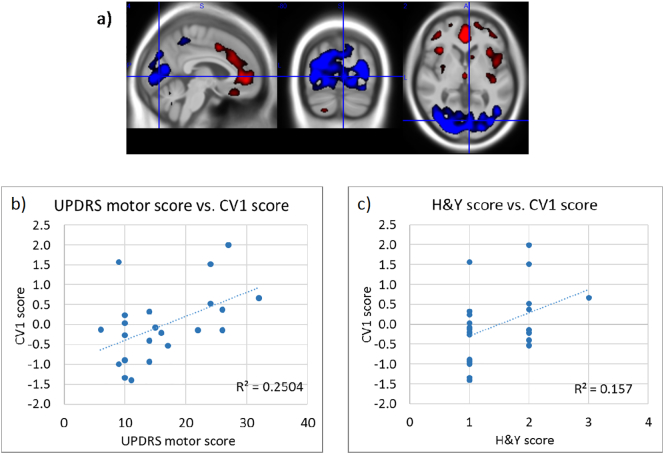
a) CV1 pattern for classifier trained on PD subjects from Hoehn & Yahr stages I vs. II & III; b) Correlation between CV1 scores and UPDRS motor scores generated through Leave-One-Out testing; c) Correlation between Leave-One-Out CV1 scores and H&Y stage. Higher CV1 scores reflect greater magnitude of expression of the PDRP.